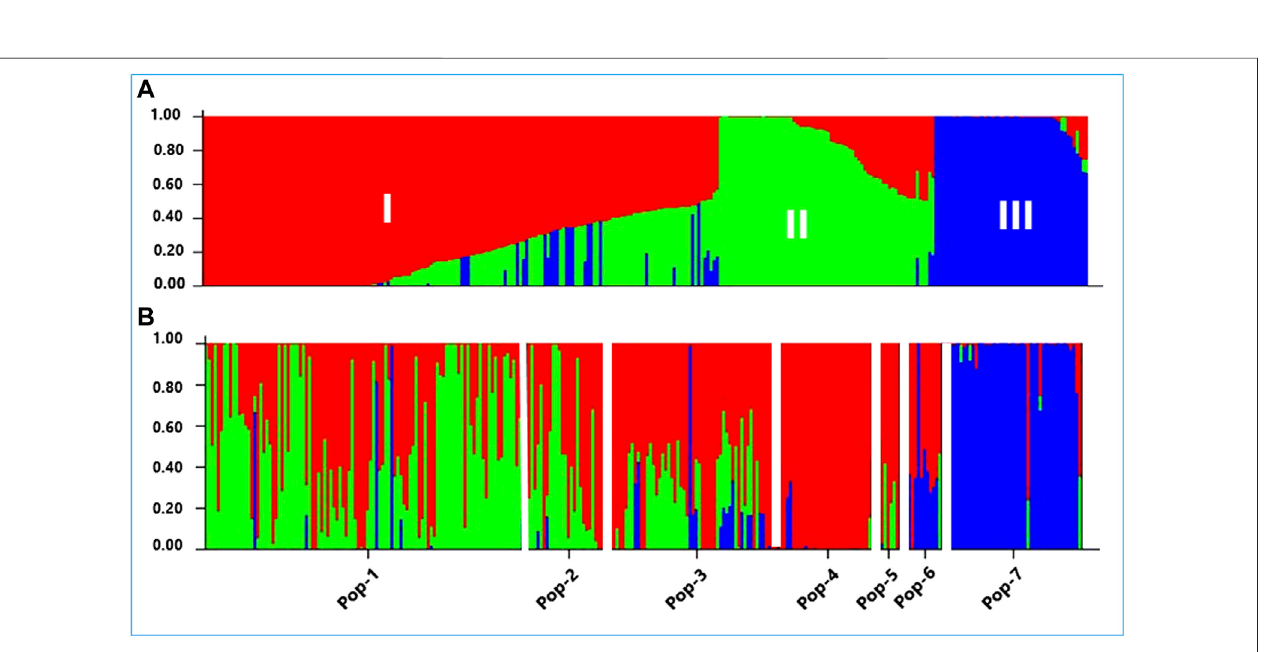
FIGURE 8 | A graphical display of the genetic structure of 288 accessions of fi nger millet at K = 3, forming three clusters (shown by different colors) and exhibiting different levels of admixture. (A) Individual accessions were arranged according to the level of their membership in different clusters and (B) individual accessions were arranged according to their assigned populations (Pop-1 to Pop-7) comprising 105, 31, 55, 28, 9, 14, and 46 accessions,